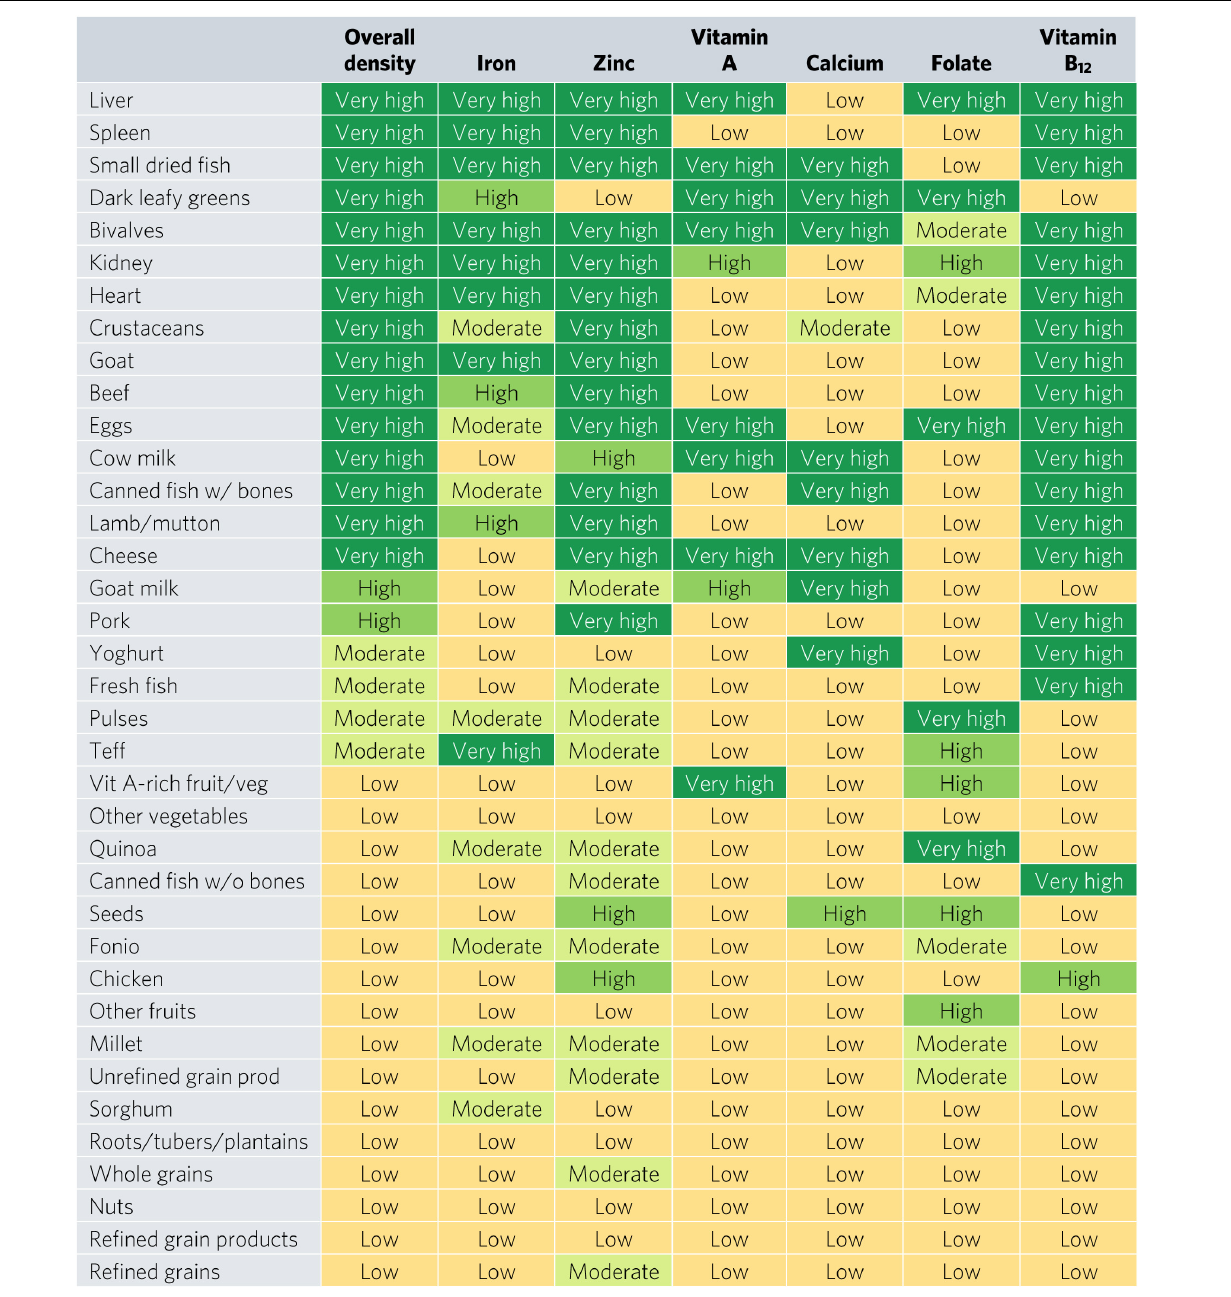
bivalves, crustaceans, ruminant meat, eggs, milk, cheese, canned fish, pork, yogurt, and fresh